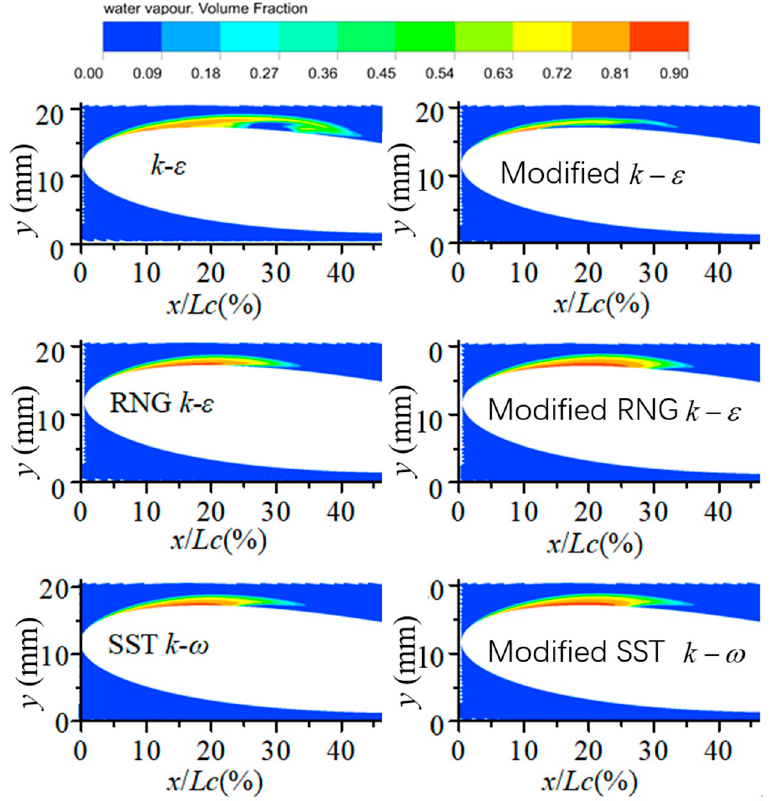
Figure 8. Vapor volume fraction distribution on the surface of the NACA0015 hydrofoil.